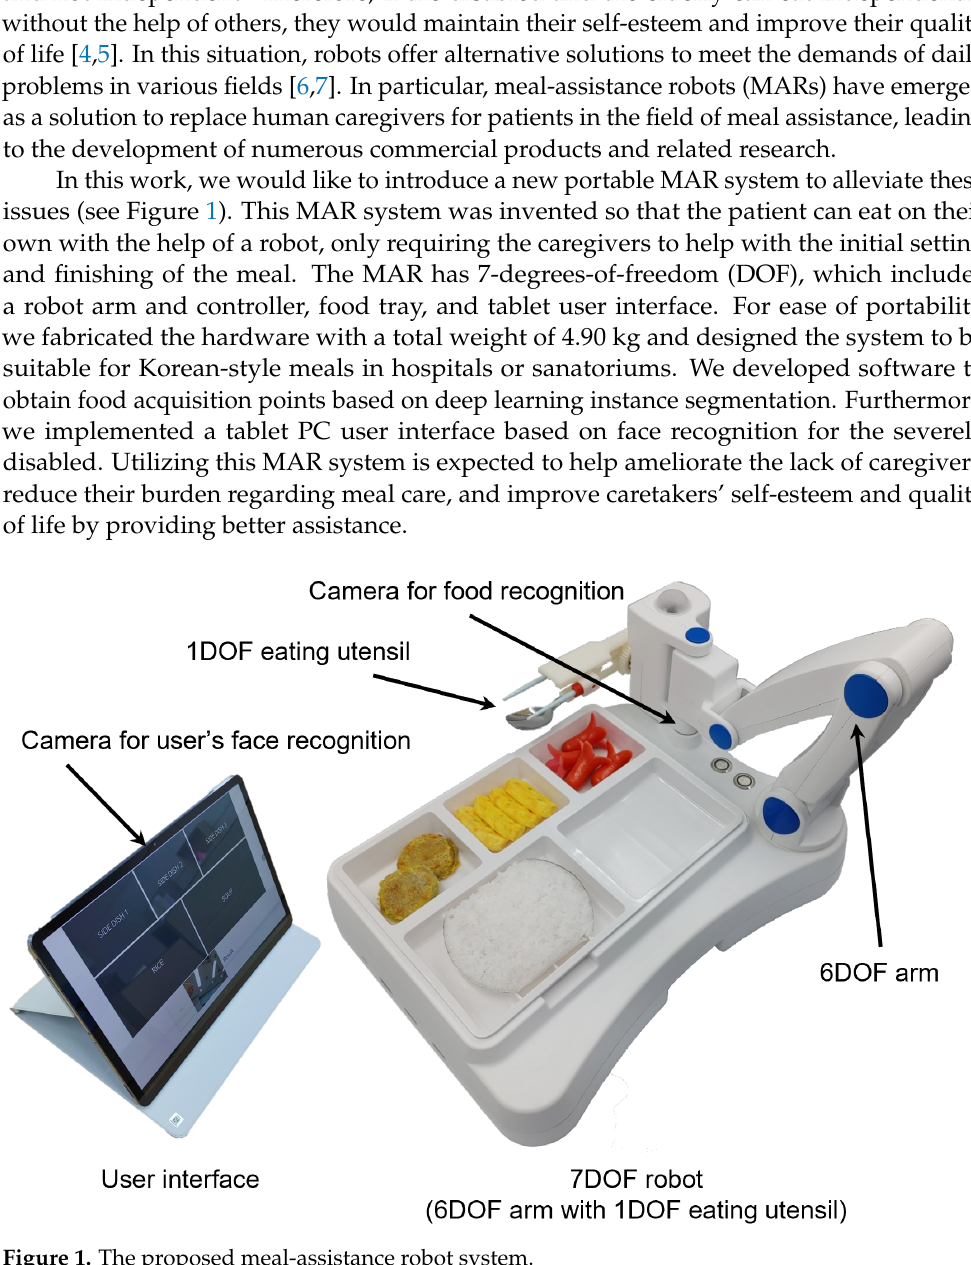
Figure 1. The proposed meal-assistance robot